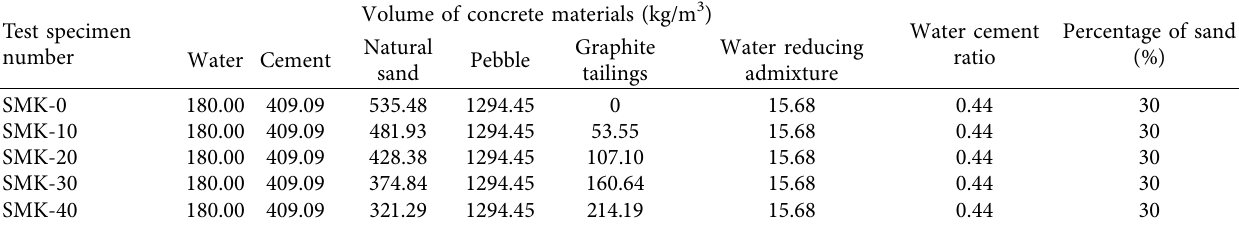
Table 2: Mix ratio and mechanical properties of 1 m 3 graphite tailing sand concrete.